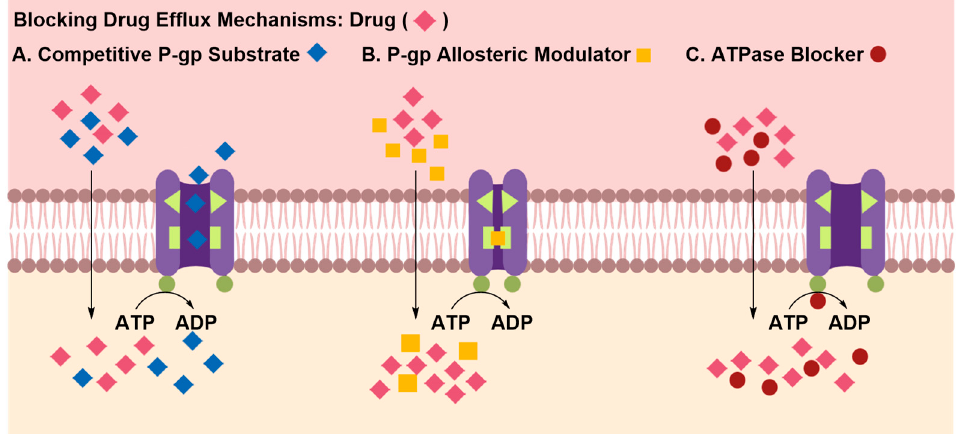
Figure 7. Regulating drug efflux by co-administration of efflux-inhibitors with the therapeutic material. Efflux inhibitors may compete for efflux pump-mediated extrusion, which favors intraparenchymal accumulation of substrates ( A ), and may bind to a site distinct from the primary substrate binding site causing the protein to undergo a conformational change that blocks the substrate binding site ( B ) or may interact with the ATPase binding site in the efflux pump, obstructing production of energy required to transport substances against their concentration gradient.